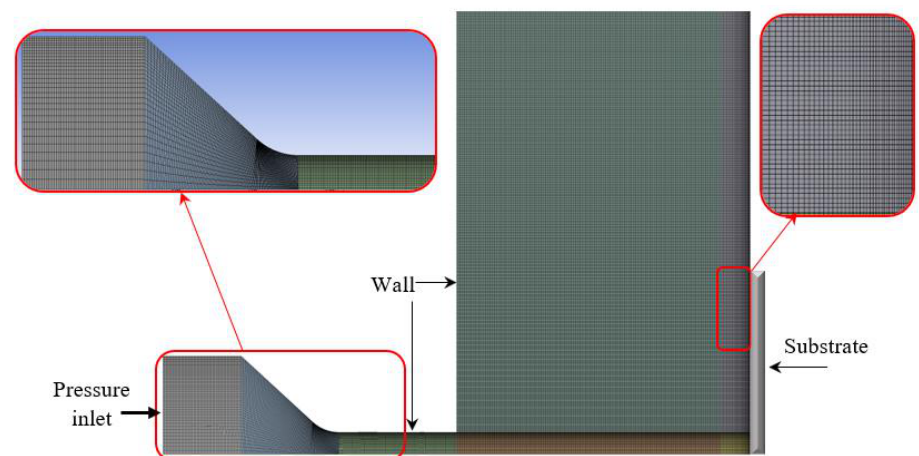
Figure 3. Boundary conditions.